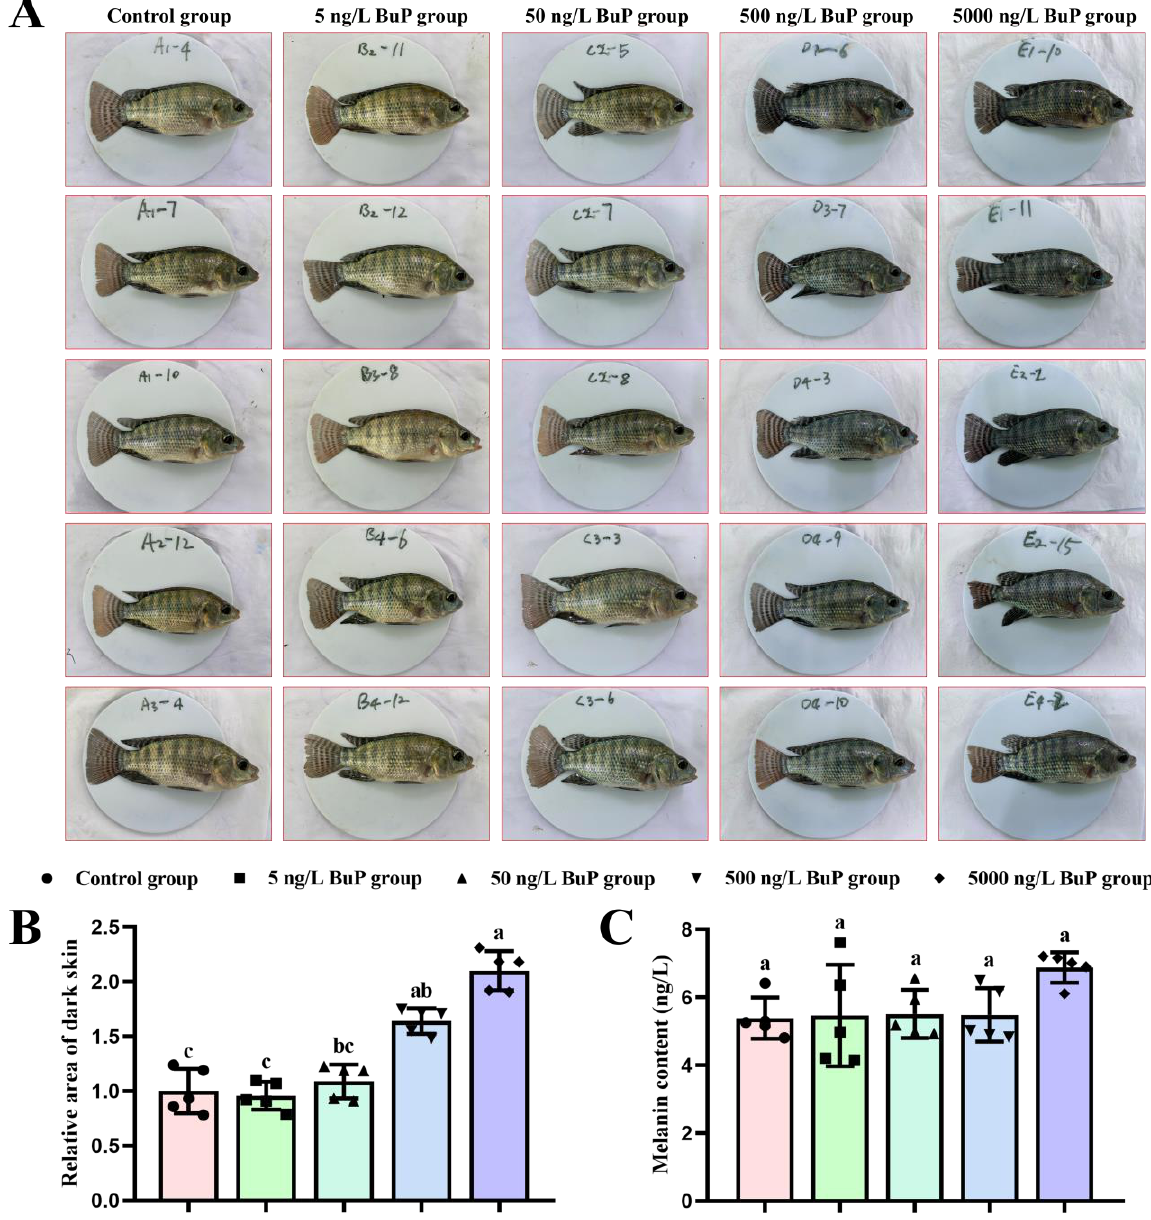
Figure 1. Effects of BuP on the melanin content in skin tissues. The pictures of fish ( A ); relative area of dark skin ( B ); and melanin content of the skin ( C ). Means of groups not sharing a common letter are significantly different at p < 0.05.